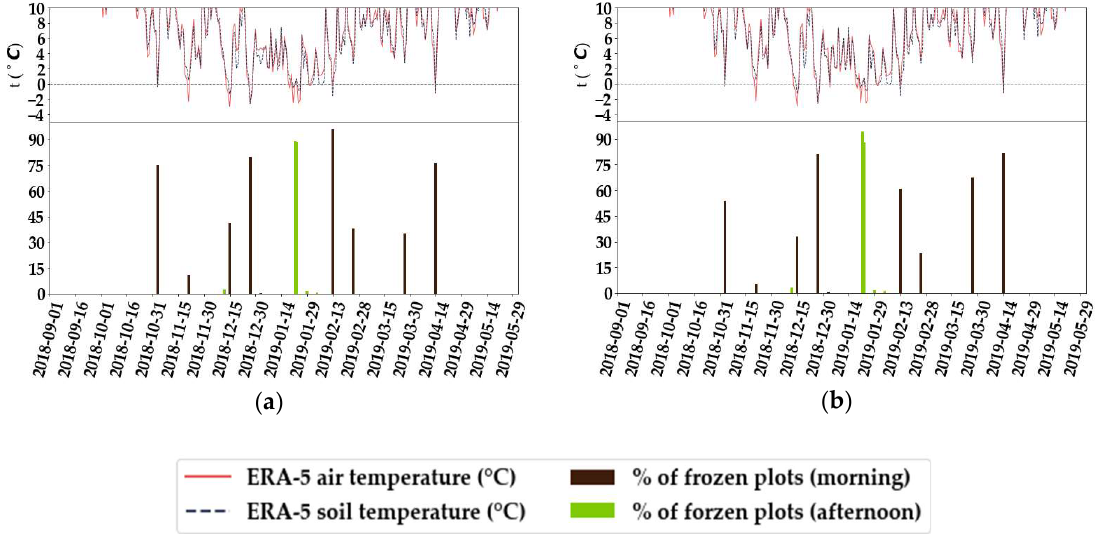
Figure 13. The distribution of frozen plots in site A in comparison to ERA5-Land’s soil and air temperatures at each S1 acquisition, and using VH and VV polarizations after applying the temperature filter. ( a ) VH, and ( b ) VV.